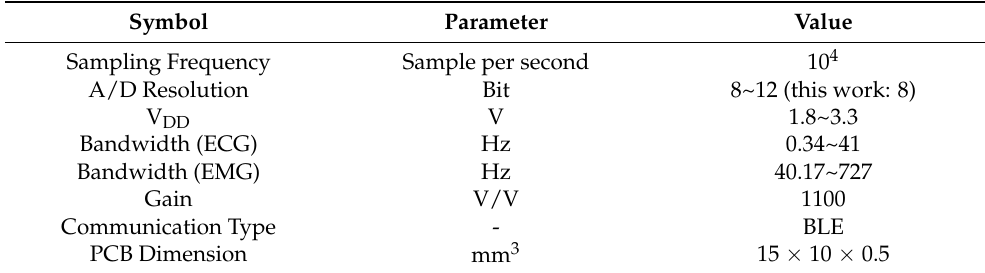
Figure 2. Schematic of the analog front-end. Amplification channel is selected from the analog multiplexer (MUX) from the microcontroller. The 2nd-order analog notch filter eliminates the powerline interference and the analog signal is delivered to the ADC for sampling. Table 1. Specification of the monitoring device